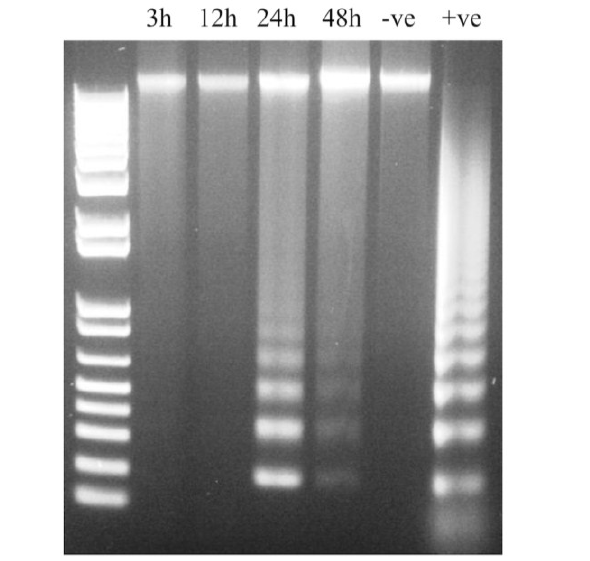
Figure 6. DNA laddering in IPNV-infected CHSE-214 cell lines. Cells were infected and harvested at the indicated time points. DNA was extracted using the Apoptotic DNA Ladder Kit (Roche) before being analyzed by gel electrophoresis. The result is representative of three independent experiments. –ve: uninfected cells; +ve: positive control.